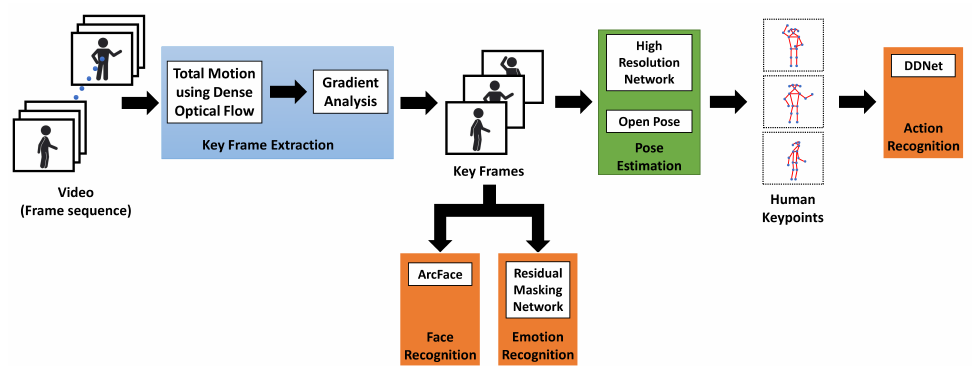
Figure 1. The proposed framework for the real-time vision system of a social robot that incorporates action recognition with face and emotion